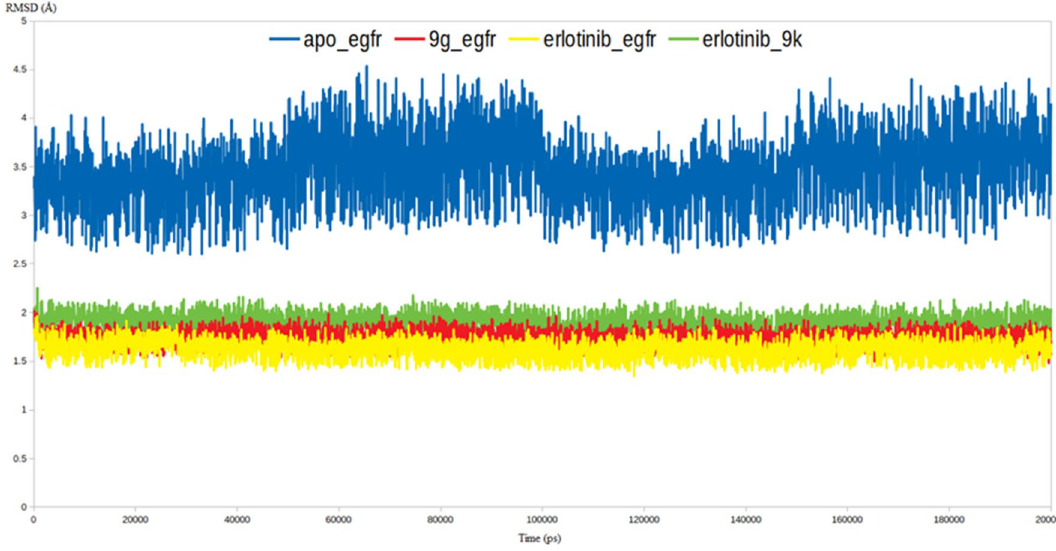
Figure 7. RMSD analysis for the MD simulations.